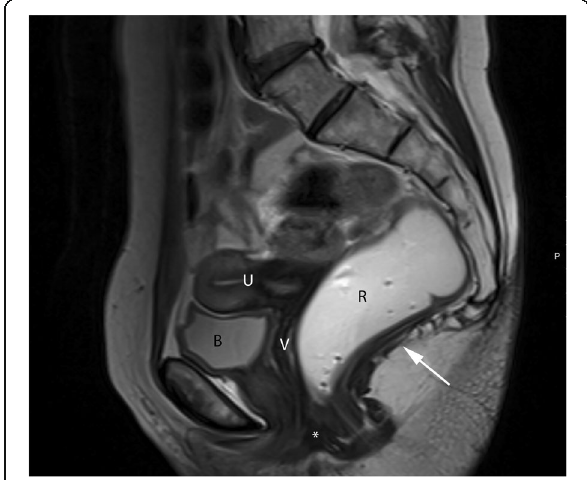
Fig. 1 Normal female pelvic anatomy. Sagittal midline T2-TSE image demonstrating the perineal body (*) and the levator plate (white arrow). B , bladder; U , uterus; V , vagina; R , rectum